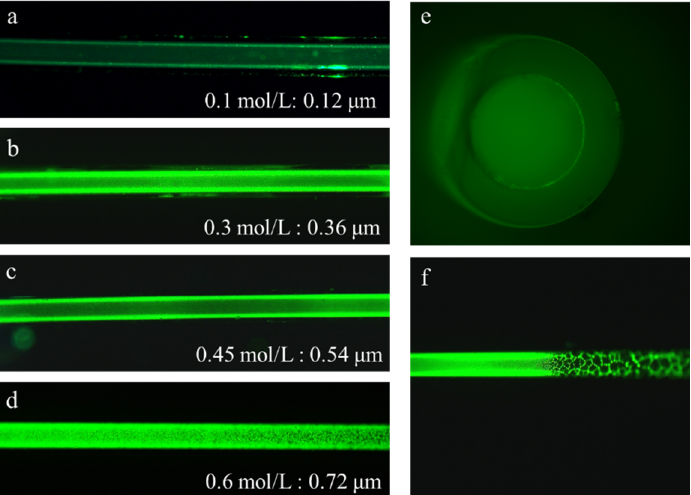
Figure 4. Diffusion modulated solvent exchange film assembly results. ( a – d ) Film assembly results incorporating different precursor concentrations. ( e ) Microscope cross-section image. ( f ) Sparsely dispersed large crystallites due to the slowed solvent exchange rate as the distance from the faucet increased to a large extent.